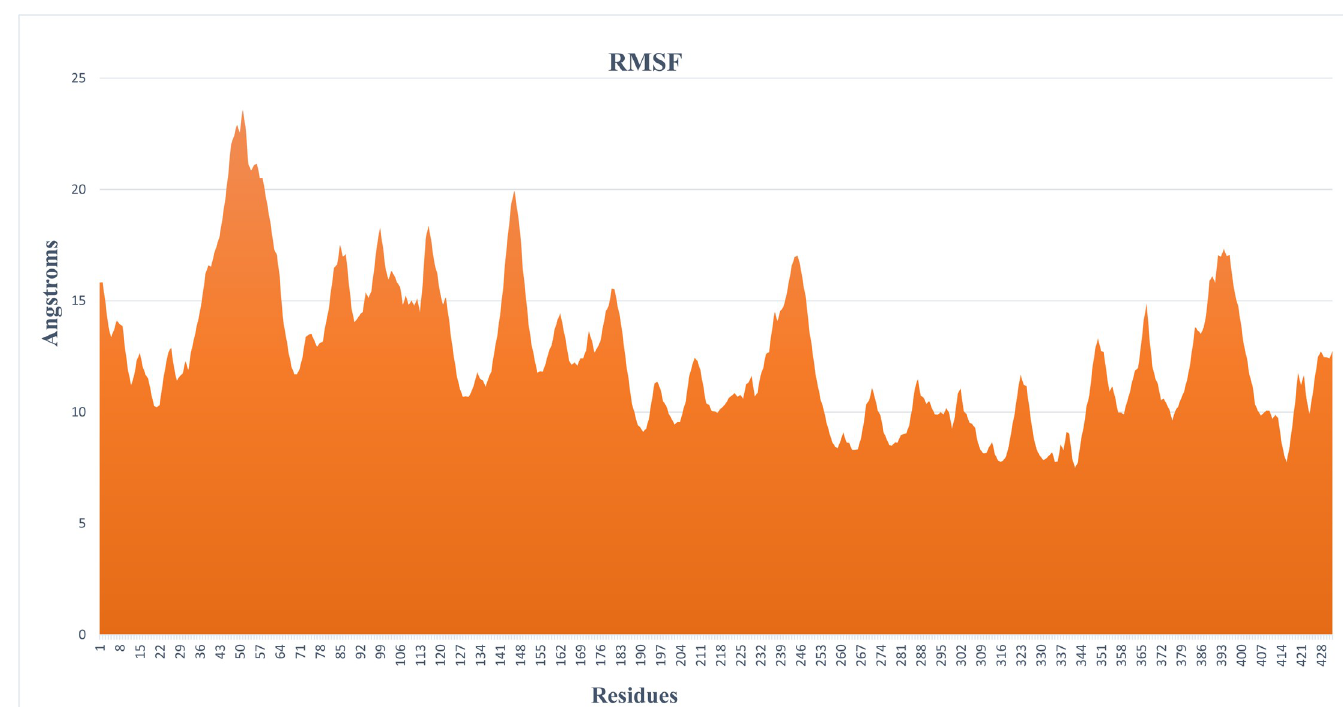
Fig 2. RMSF fluctuation graph showed the variations of individual residues from 0–30